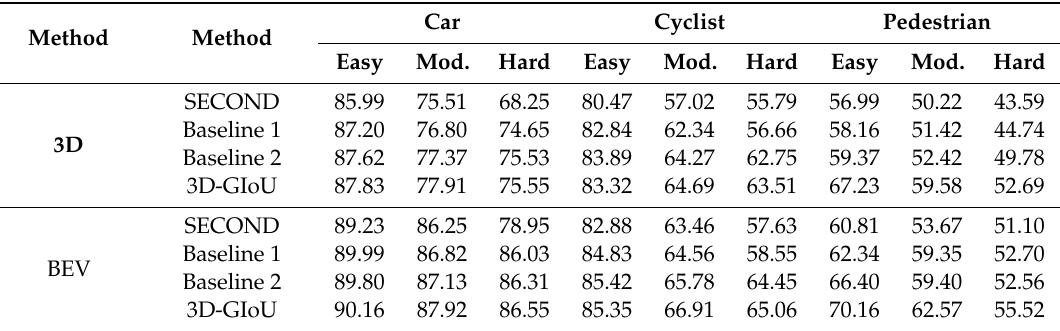
Table 3. 3D and BEV detection performance: AP (%) on the KITTI valuation